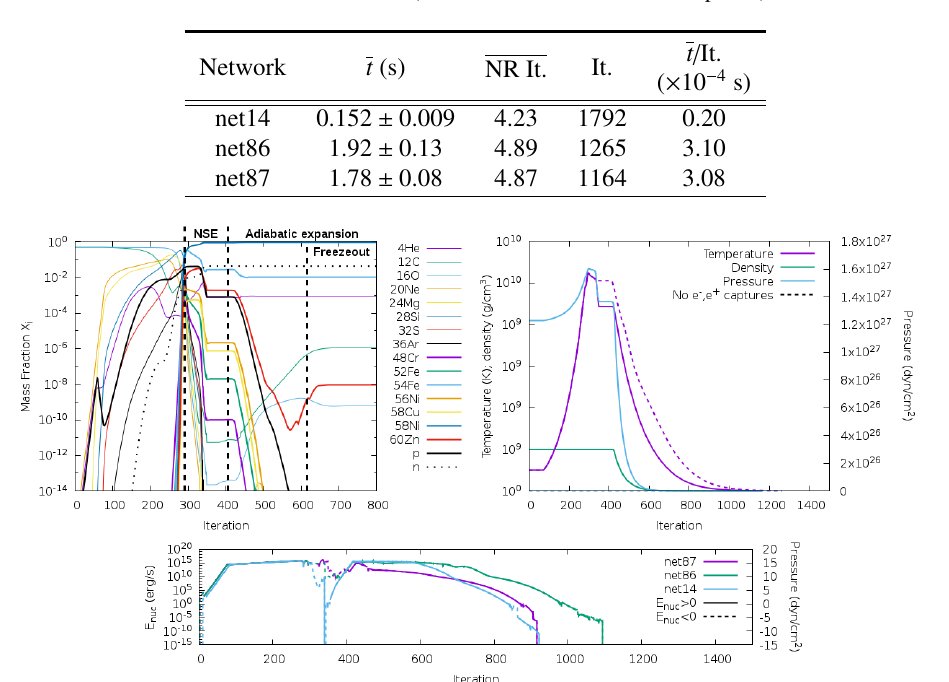
Table 1. Wall-clock time, average number of Newton-Raphson iterations per global iteration, total number of global iterations, and average wall-clock time per single iteration for the 12 C + 16 O test and for each nuclear network ( net86 is net87 without e − , e + -captures)